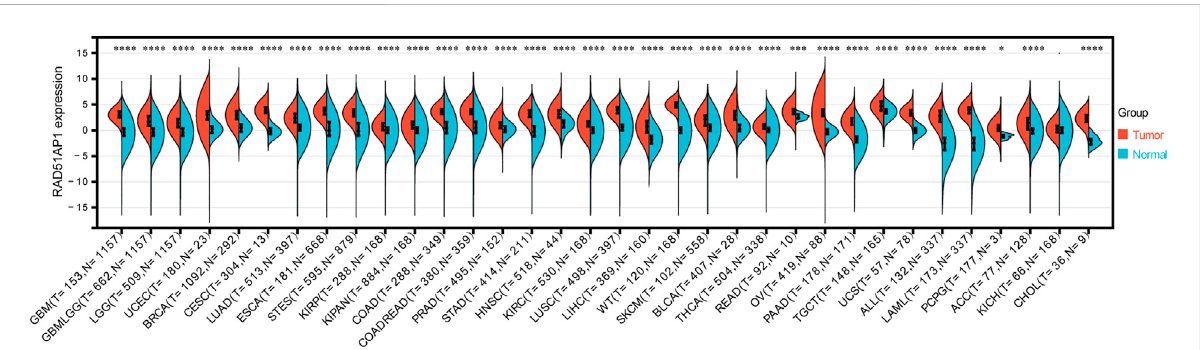
FIGURE 2 Differential expression analysis of RAD51AP1 in pan-cancer. All available expression data in 34 cancer types were performed differential expression analysis. Thirty-there cancer types including GBM( p = 2.2e-88), GBMLGG ( p = 1.4e-189), LGG ( p = 2.9e-141), UCEC ( p = 2.0e-10), BRCA ( p = 2.1e-121), CESC( p = 2.3e-9), LUAD ( p = 9.1e-89), ESCA( p = 7.7e-86), STES ( p = 1.8e-198), KIRP ( p = 1.2e-12), KIPAN ( p = 1.9e-30), COAD ( p = 1.4e-98), COADREAD ( p = 1.2e-112), PRAD ( p = 1.3e-17), STAD ( p = 7.5e-85), HNSC( p = 3.2e-20), KIRC ( p = 7.3e-42), LUSC( p = 1.6e-141), LIHC( p = 3.6e-44), WT ( p = 2.3e-47), SKCM( p = 9.0e-23), BLCA ( p = 5.9e-12), THCA( p = 3.8e-34), READ ( p = 1.9e-4), OV( p = 2.6e-48), PAAD ( p = 6.5e-53), TGCT ( p = 1.9e-18), UCS( p = 5.3e-23), ALL ( p = 6.0e-60), LAML ( p = 5.1e-76) and PCPG ( p = 0.02) presented signi fi cantly overexpressed RAD51AP1 in tumor